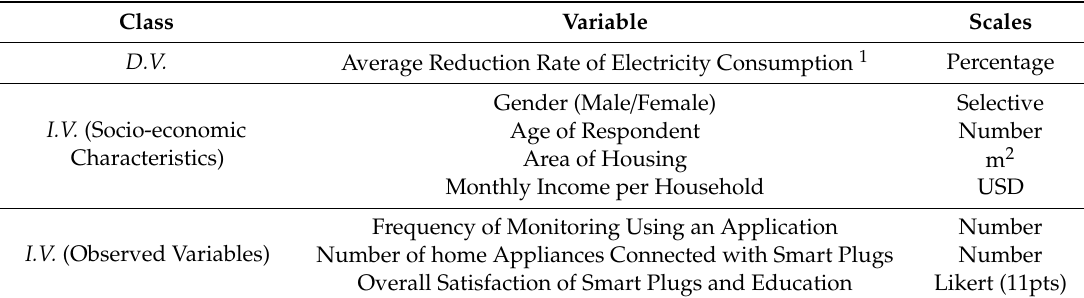
Table 1. Dependent ( D.V. ) and Independent ( I.V. ) Variables of Research Model I.